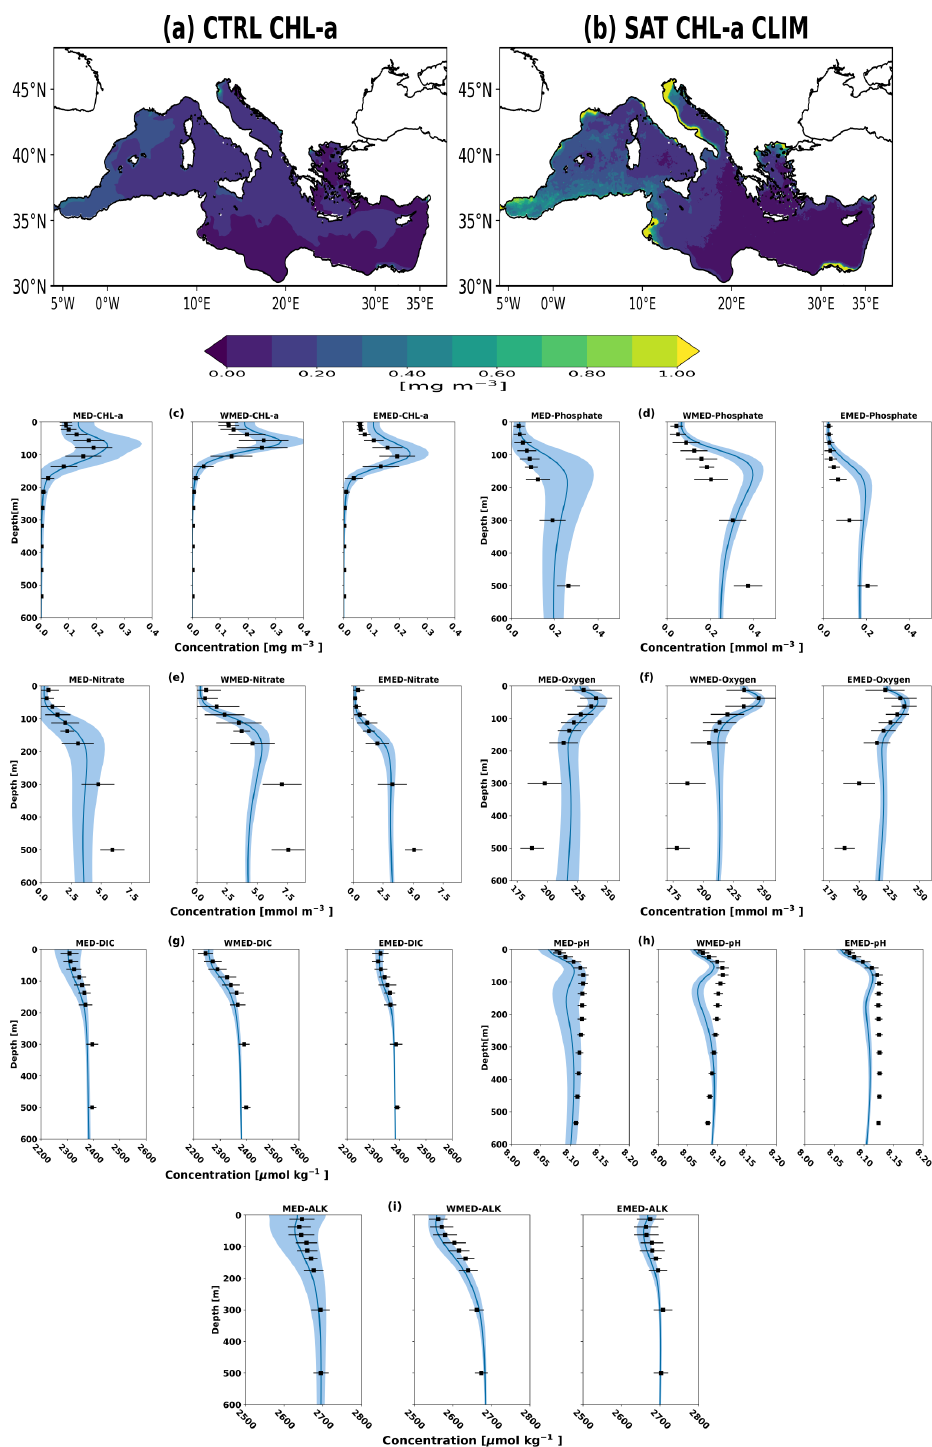
Figure 2. Average Chl- a in the first 10m in CTRL for the period 2005–2020 (a) and CMEMS-SAT (b) , together with CTRL average vertical profiles (blue lines) for the period 2005–2020 of Chl- a ( c , mgm − 3 ), PO 4 ( d , mmolm − 3 ), NO 3 ( e , mmolm − 3 ), dissolved oxy- gen ( f , mmolm − 3 ), DIC ( g , µmolkg − 1 ), pH (h) and ALK ( i , µmolkg − 1 ). The averaged profiles are computed for the entire (MED), the Western (WMED) and the Eastern (EMED) Mediterranean Sea. The light blue areas represent the spatial standard deviation of the monthly model data. The model data are compared with CMEMS reanalysis (Chl- a and pH; Colella et al., 2016: Teruzzi et al., 2021) and observa- tions provided by EMODnet (PO 4 , NO 3 , dissolved oxygen, DIC, ALK; Buga et al., 2018): annual means (black squares) and related standard deviations (black bars). Depths are measured in